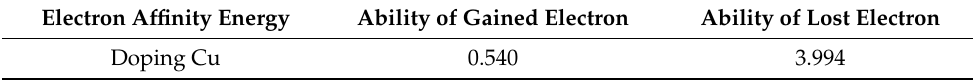
Table 1. Electron affinity of different defect systems.